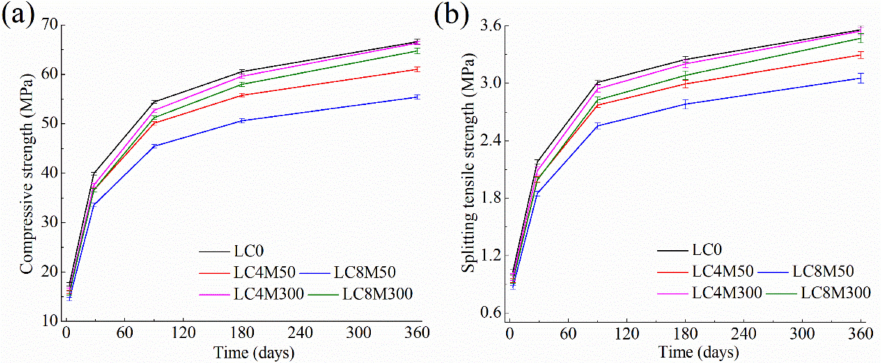
Figure 2. Mechanical property of LHP concrete containing MgO: ( a ) compressive strength and ( b ) splitting tensile